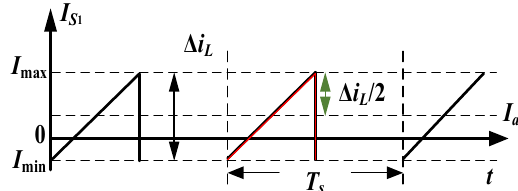
Figure A2. The current waveform of S 1 for I min ≤ 0. When I min ≤ 0, the turn-on loss